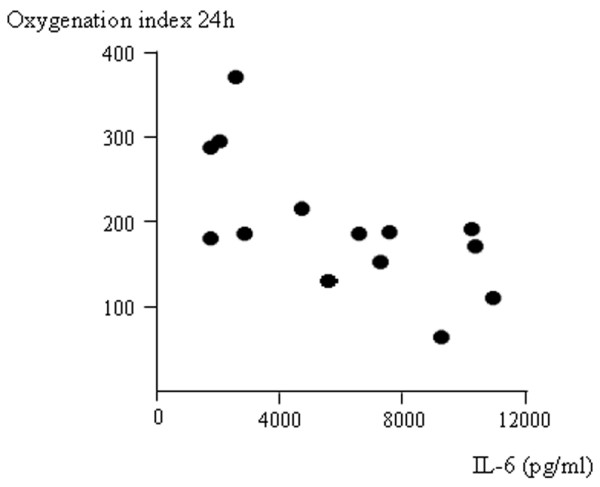
Relationship between preoperative production of interleukin-6 (IL-6) and postoperative pulmonary dysfunction. Plot showing the correlation between preoperative IL-6 production after stimulation with lipopolysaccharide (LPS) and the oxygenation index 24 hours after operation (n = 14). Spearman correlation coefficient -0.62; P < 0.02.